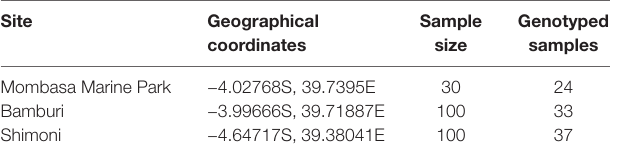
TABLE 1 | Description of sampling location and number of samples collected and genotyped from Mombasa Marine Park, Bamburi, and Shimoni fishing grounds in coastal